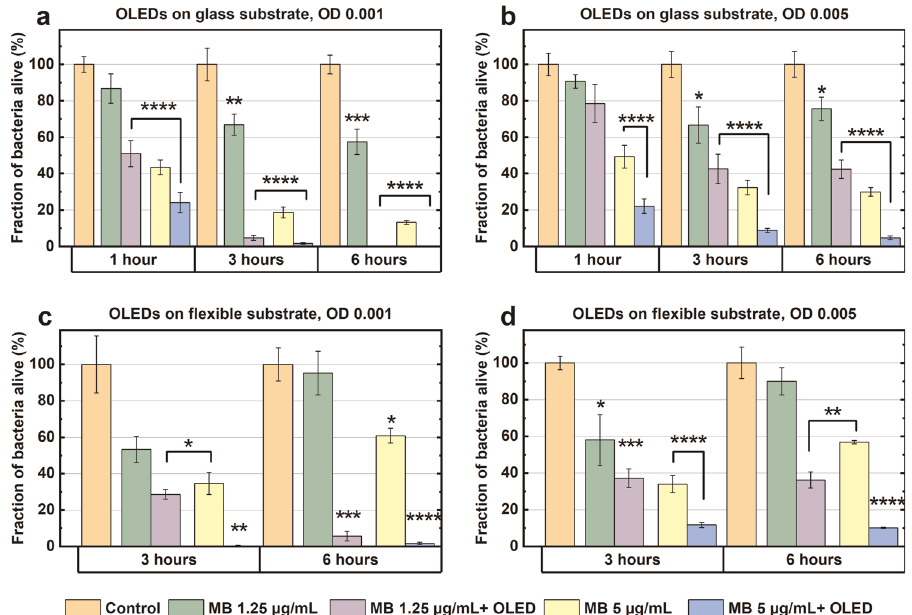
Fig. 3 Biological results of OLED – PDT for killing S. aureus . The results show the fraction of bacteria alive for a range of conditions of illumination and photosensitizer concentrations. Each set of fi ve bars shows the results for a control (no light, no photosensitizer); 1.25 µg/mL methylene blue but no light; 1.25 µg/mL methylene blue with OLED illumination for the stated times; 5 µg/mL methylene blue but no light; 5 µg/mL methylene blue with OLED illumination for the stated times. For each set of conditions performed with OLEDs on glass substrates, there were three biological repetitions, each with three technical repetitions, i.e. nine samples were measured ( n = 9). For the experiments performed with OLEDs on fl exible substrates, three samples were measured in each condition ( n = 3). The mean and standard deviation of each set of measurements is shown. Statistical signi fi cance compared to control (* p < 0.05, ** p < 0.01, *** p < 0.001, **** p <